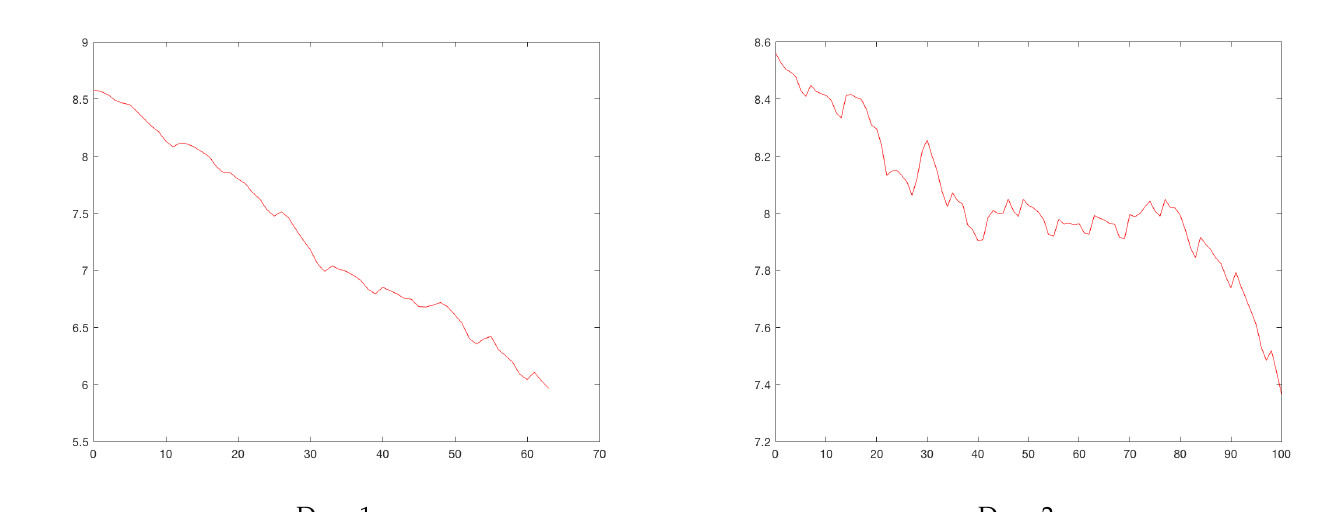
Drop 1 Drop 2 Figure A22. New York’s drops. Horizontal axis, days; vertical axis: logarithm of daily cases.